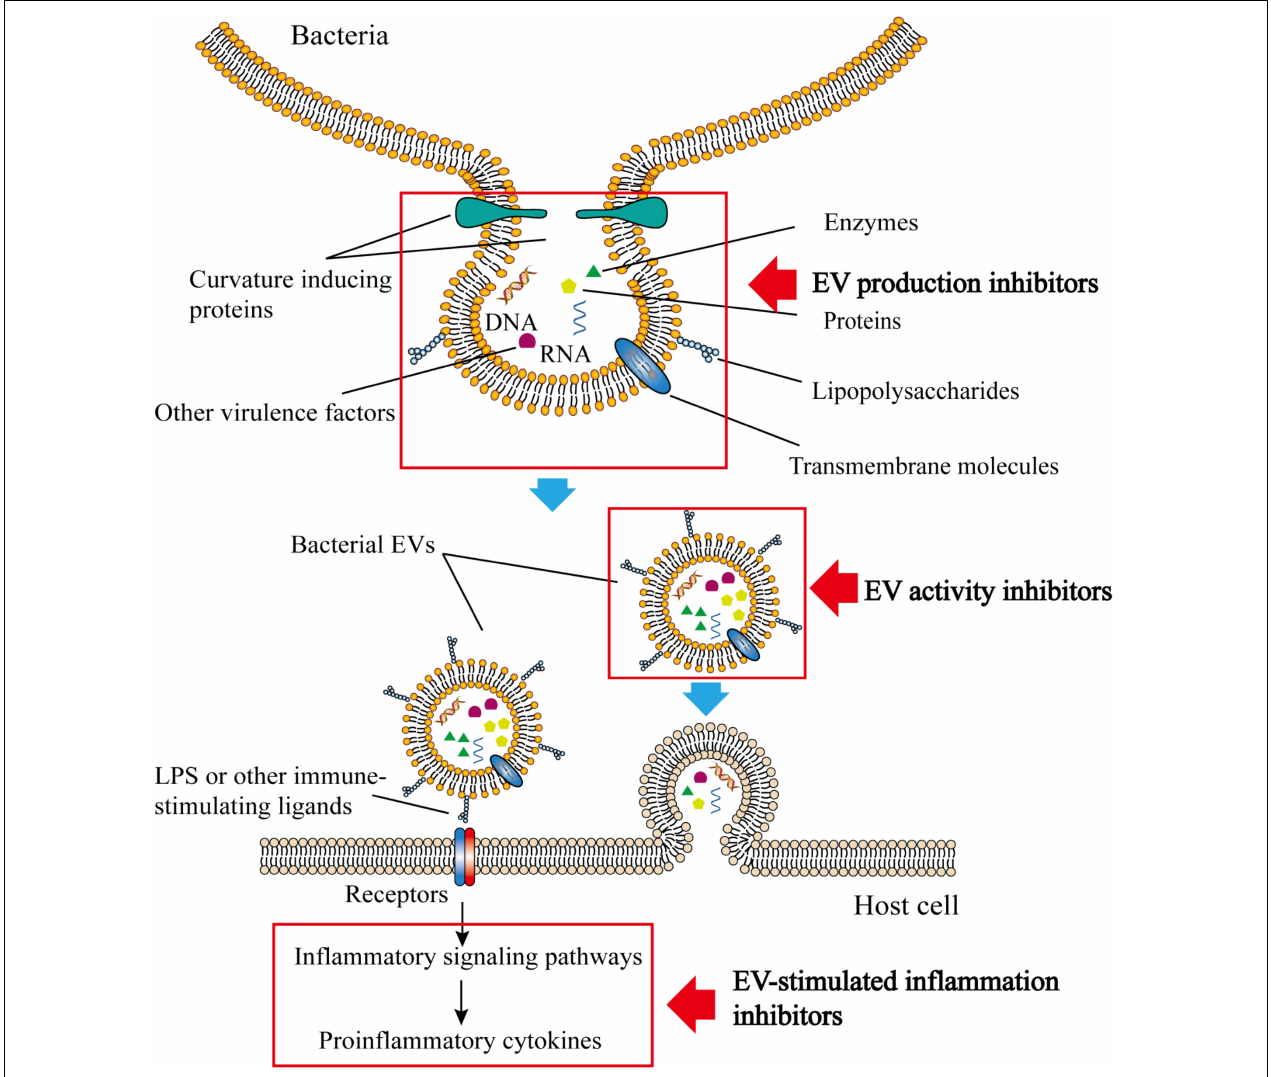
FIGURE 1 | Structure, composition and function of bacterial EVs. Bacterial EVs carry various active substances and can be transferred into host cells by endocytosis. The immunogenicity of bacterial EVs is sufficient to stimulate the immune inflammatory response of the host. Inhibitors of bacterial vesicles typically target the production of bacterial EVs, their activity, or the inflammatory response that bacterial vesicles